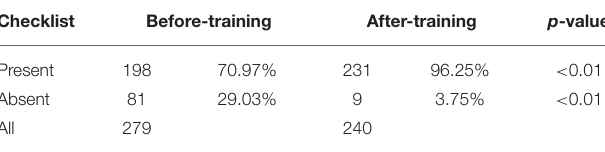
TABLE 1 | Completeness of